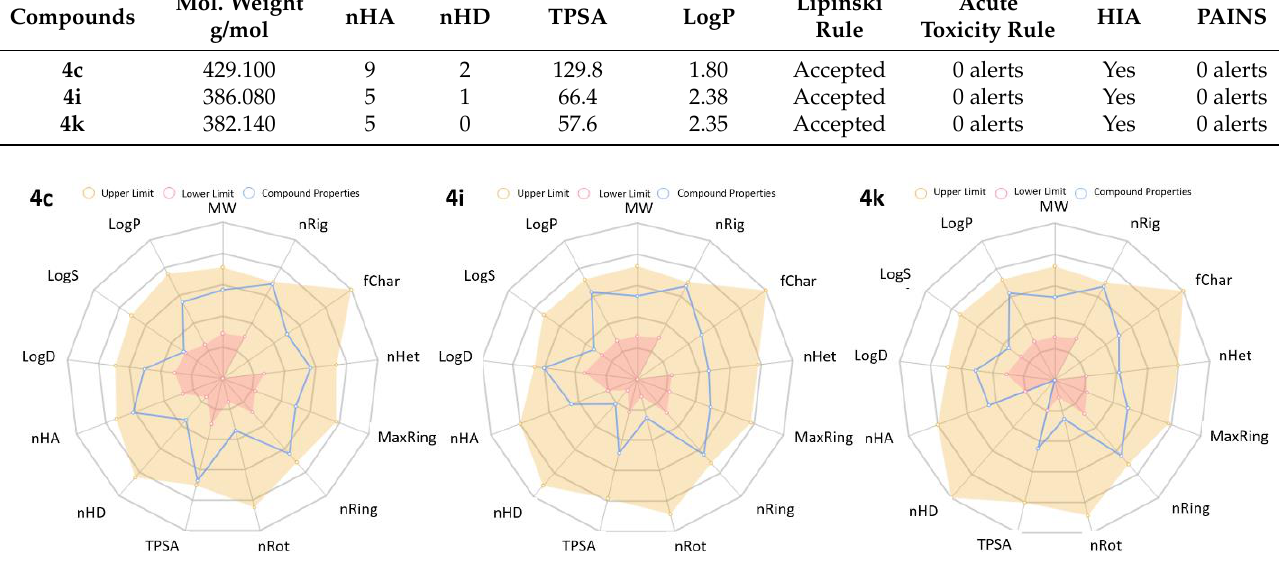
Figure 6. In silico ADMET properties of selected spirooxindole analogs predicted by ADMETlab.